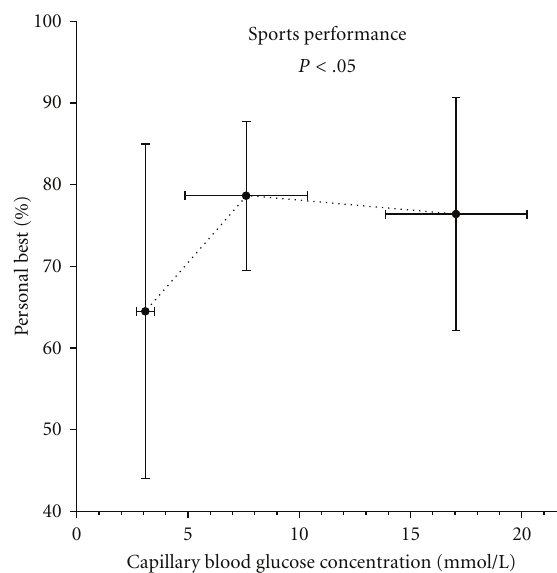
Figure 1: Sports skill performance score at each of the three categories of glycemia. Scores are shown as a percentage of personal best during the week. Scores during hypoglycemia were significantly lower than euglycemia or hyperglycemia. See methods section for a complete description. Mean ± SD. A significant main e ff ect of glucose category on performance was found. Post hoc analysis reveled that performance in hypoglycemia was less than euglycemia and hyperglycemia at P < .